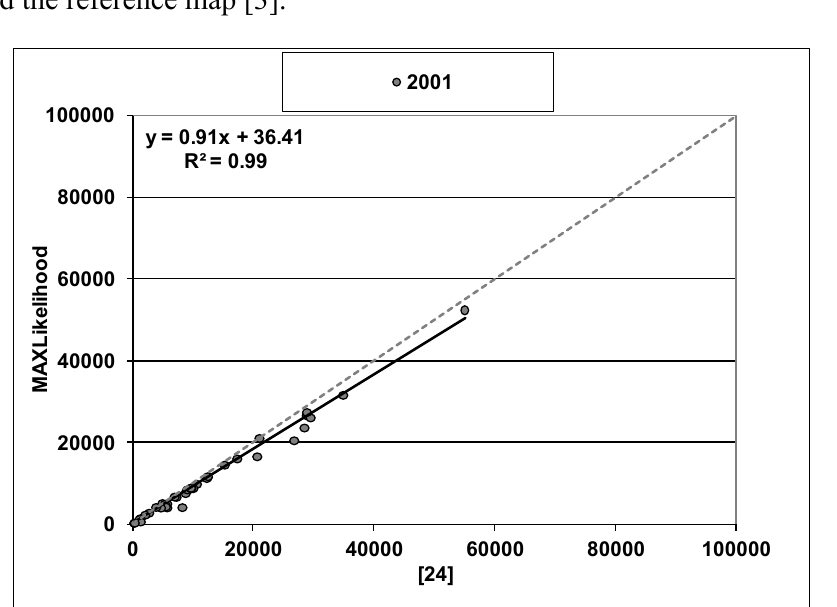
Figure 5. Scatterplot diagram and regression analysis, of soybean area estimates, between ML map and the reference map